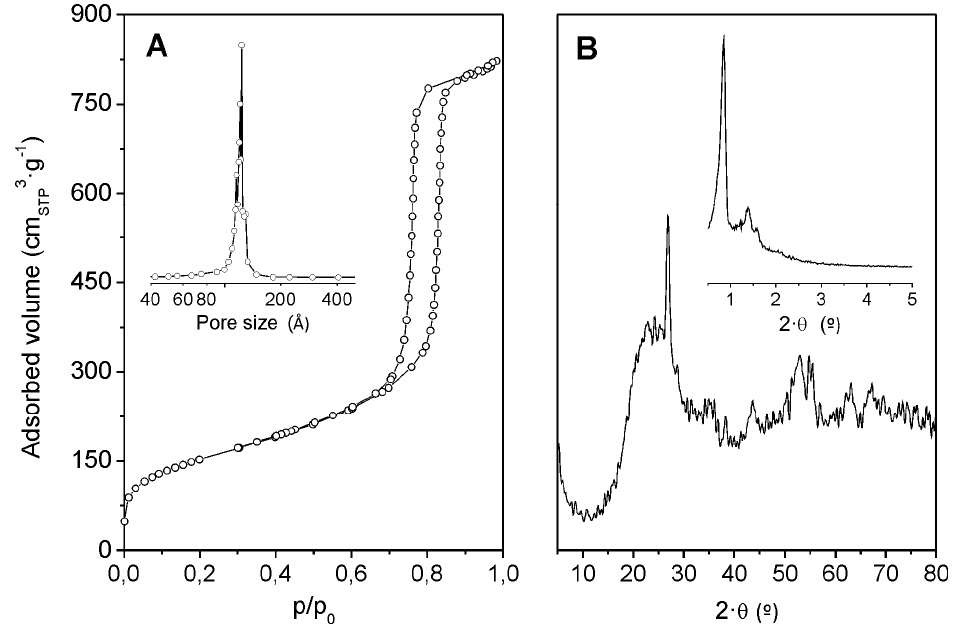
Figure 1. Characterization results for Zr-SBA-15 catalyst: ( A ) N 2 adsorption-desorption isotherm and pore sizes distribution (inset); and ( B ) X-Ray Diffraction patterns at high and low (inset) angle